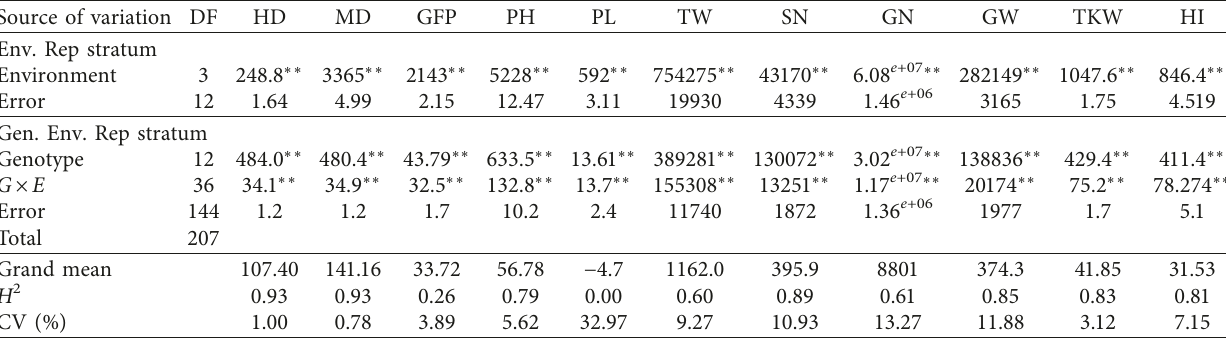
Table 3: Mean squares from combined ANOVA of 13 barley genotypes grown across four different environments. Source of variation DF